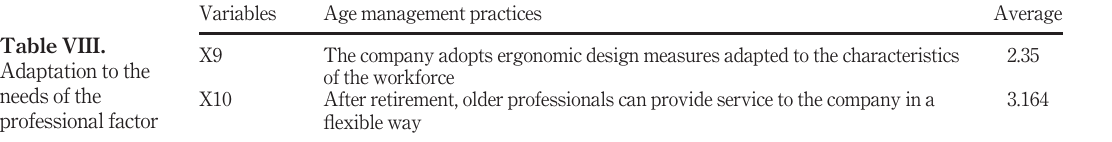
Table VII. Retention and permanence in the company